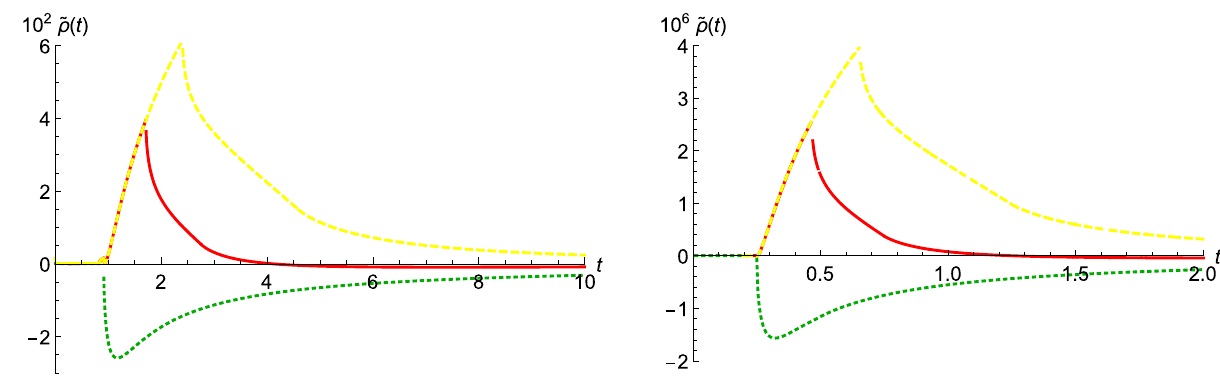
Fig. 4 Spectral functions for the propagator (cid:2) A a μ ( p ) A b ν ( − p ) (cid:3) T , for ξ = 1 (green, dotted), ξ = 3 (red, solid), ξ = 5 (yellow, dashed), with t given in units of μ 2 , for Region I (left) and Region II (right) with the parameter values given in Table 1